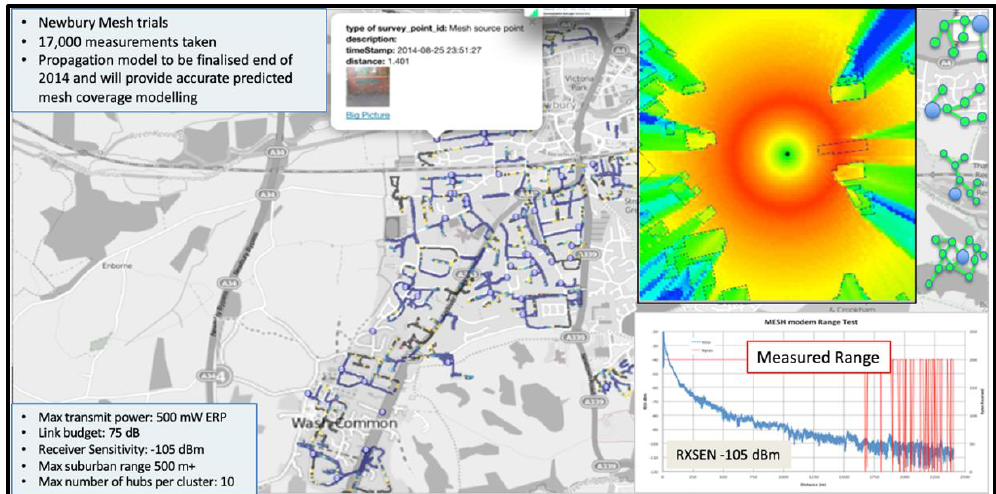
Figure 4. Coverage map of where the measurements were made in Newbury.